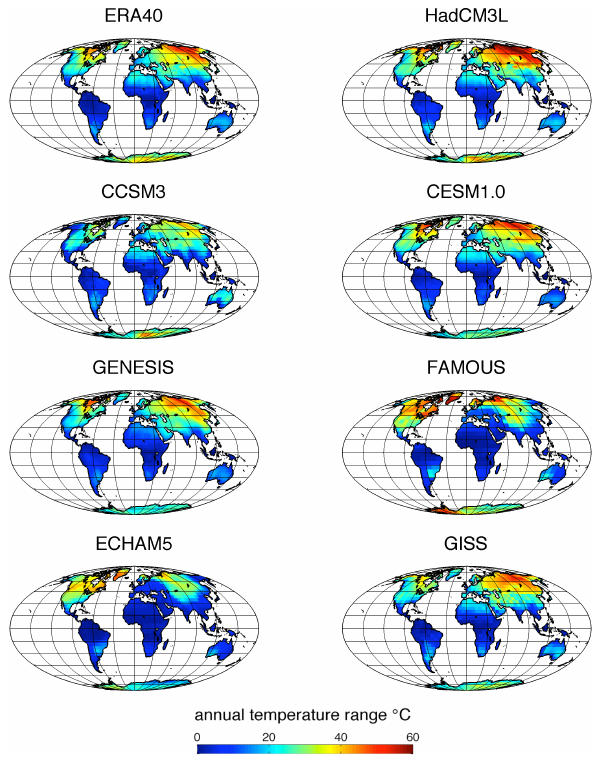
Fig. 10. Annual surface air temperature range from modern/pre-industrial control GCM simulations and ERA-40 re-analysis data set.